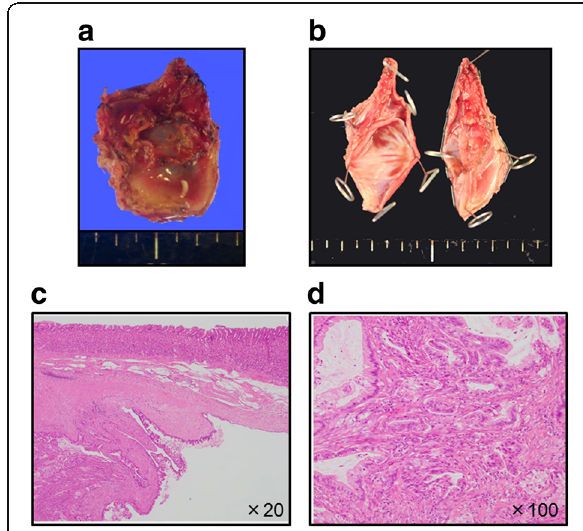
Fig. 5 Pathological findings of the cystic gastric metastasis. Macroscopically, there was a 25-mm round cystic tumor ( a , b ). Microscopically, the cystic tumor existed in the submucosal layer ( c ). The tumor comprised tubular adenocarcinoma cells ( d ). Invasion of the adenocarcinoma cells did not reach the